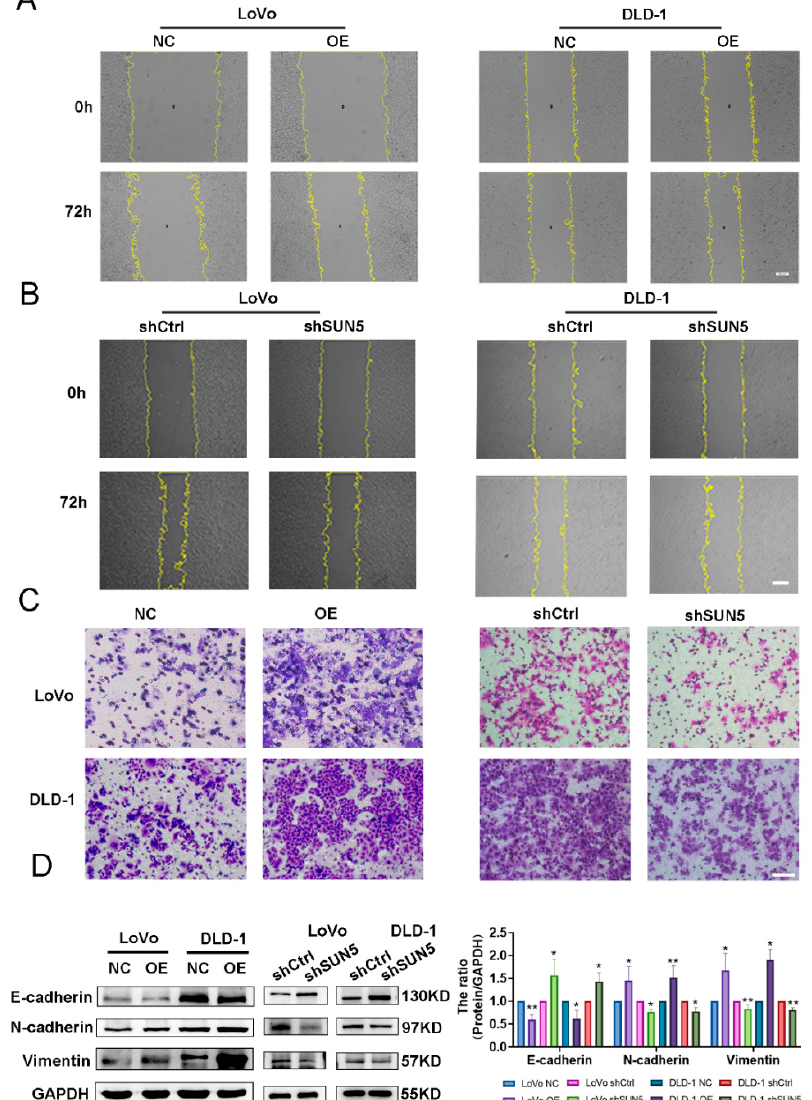
Figure 3. Overexpression of SUN5 promoted migration, while knockdown of SUN5 inhibited the migration of colorectal cancer cells in vitro. ( A – C ) Overexpression or knockdown of SUN5 promoted or inhibited cell migration as analyzed by wound-healing (scale bar: 200 µ m) and Transwell assay (scale bar: 100 µ m). ( D ) E-cadherin, N-cadherin, and vimentin were determined by Western blotting after overexpression or knockdown of SUN5 in LoVo and DLD-1 cells (* p < 0.05, ** p <